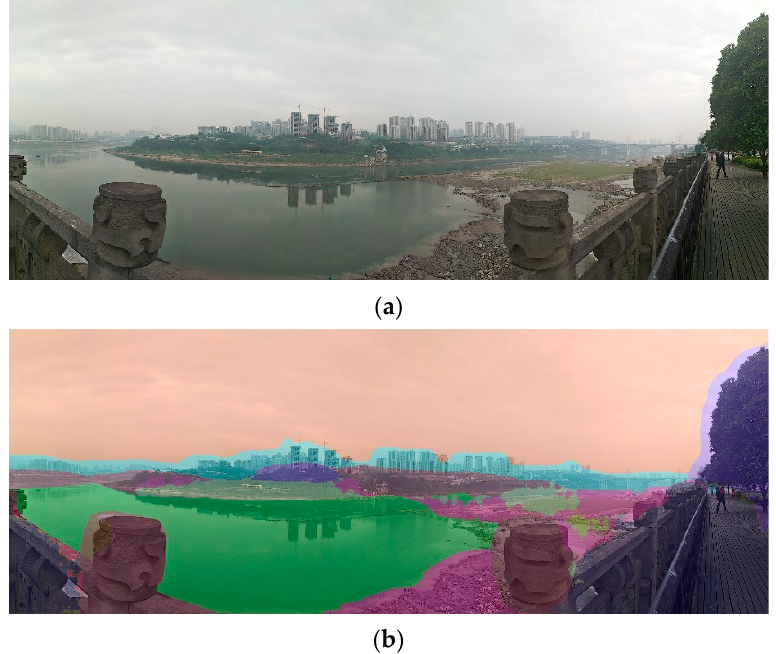
Figure 3. Visual element recognition in street-view images: ( a ) raw image and ( b ) the same image